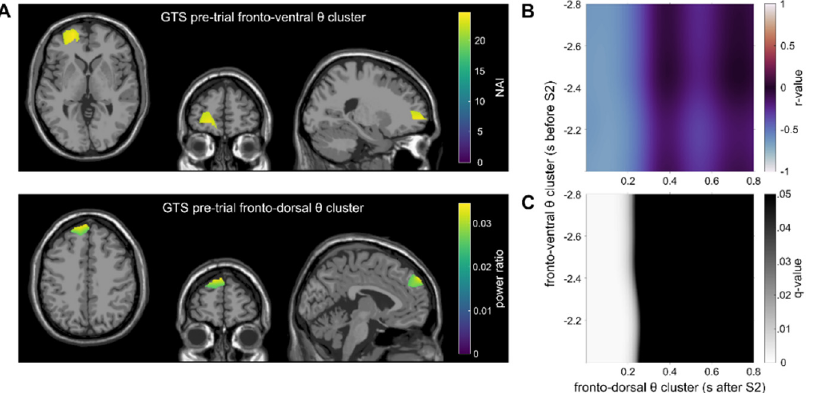
Figure 4. Main results of the correlations in the GTS group are shown. ( A ) Theta clusters: the top figure depicts theta band activity in the fronto-ventral cluster as identified by the DBSCAN algorithm in the pre-trial interval. The Neural Activity Index (NAI) is shown for voxels within the cluster. The bottom figure depicts the within-trial left fronto-dorsal theta cluster. For voxels within the cluster, the source ratio (difference between the feature overlap levels divided by the sum of the overlap levels) is color-coded. ( B ) The correlation map between the clusters from Figure 3A is shown. The correlation map shows the Pearson correlation for each time point between the pre- and within-trial tasks (color represents the r -value). ( C ) FDR-corrected q -values for the correlation map Figure 3B. Black areas indicate no significant correlation ( q > 0.05), whereas bright areas indicate a significant correlation.